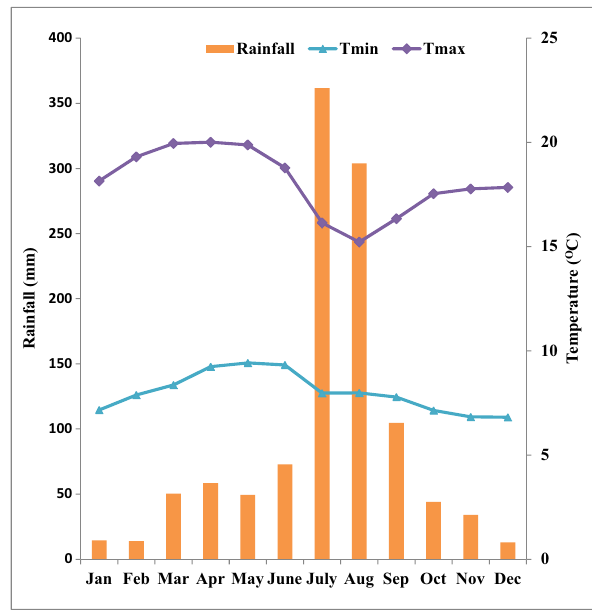
Figure 1: Fifteen years ’ ( 2004 – 2018 ) mean rainfall and minimum and maximum temperatures of the study site ( T min = minimum tem - perature, T max = maximum temperature )